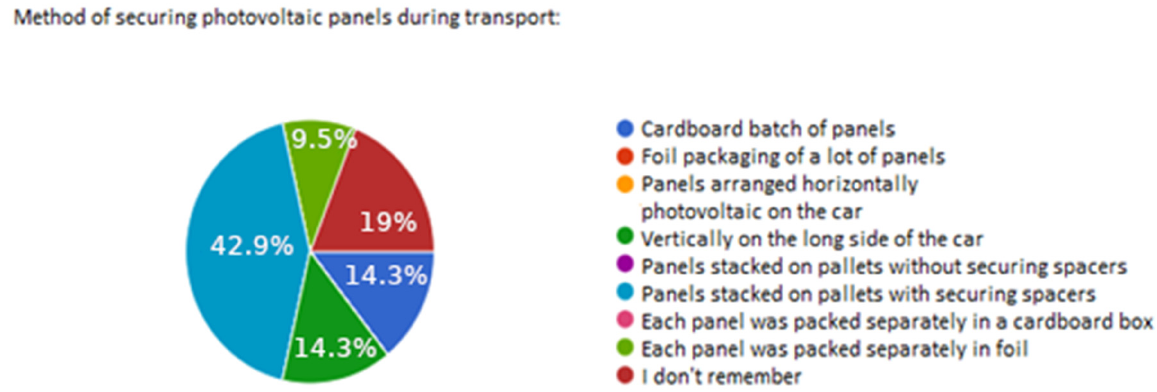
Figure 11. Packaging methods for photovoltaic panels.